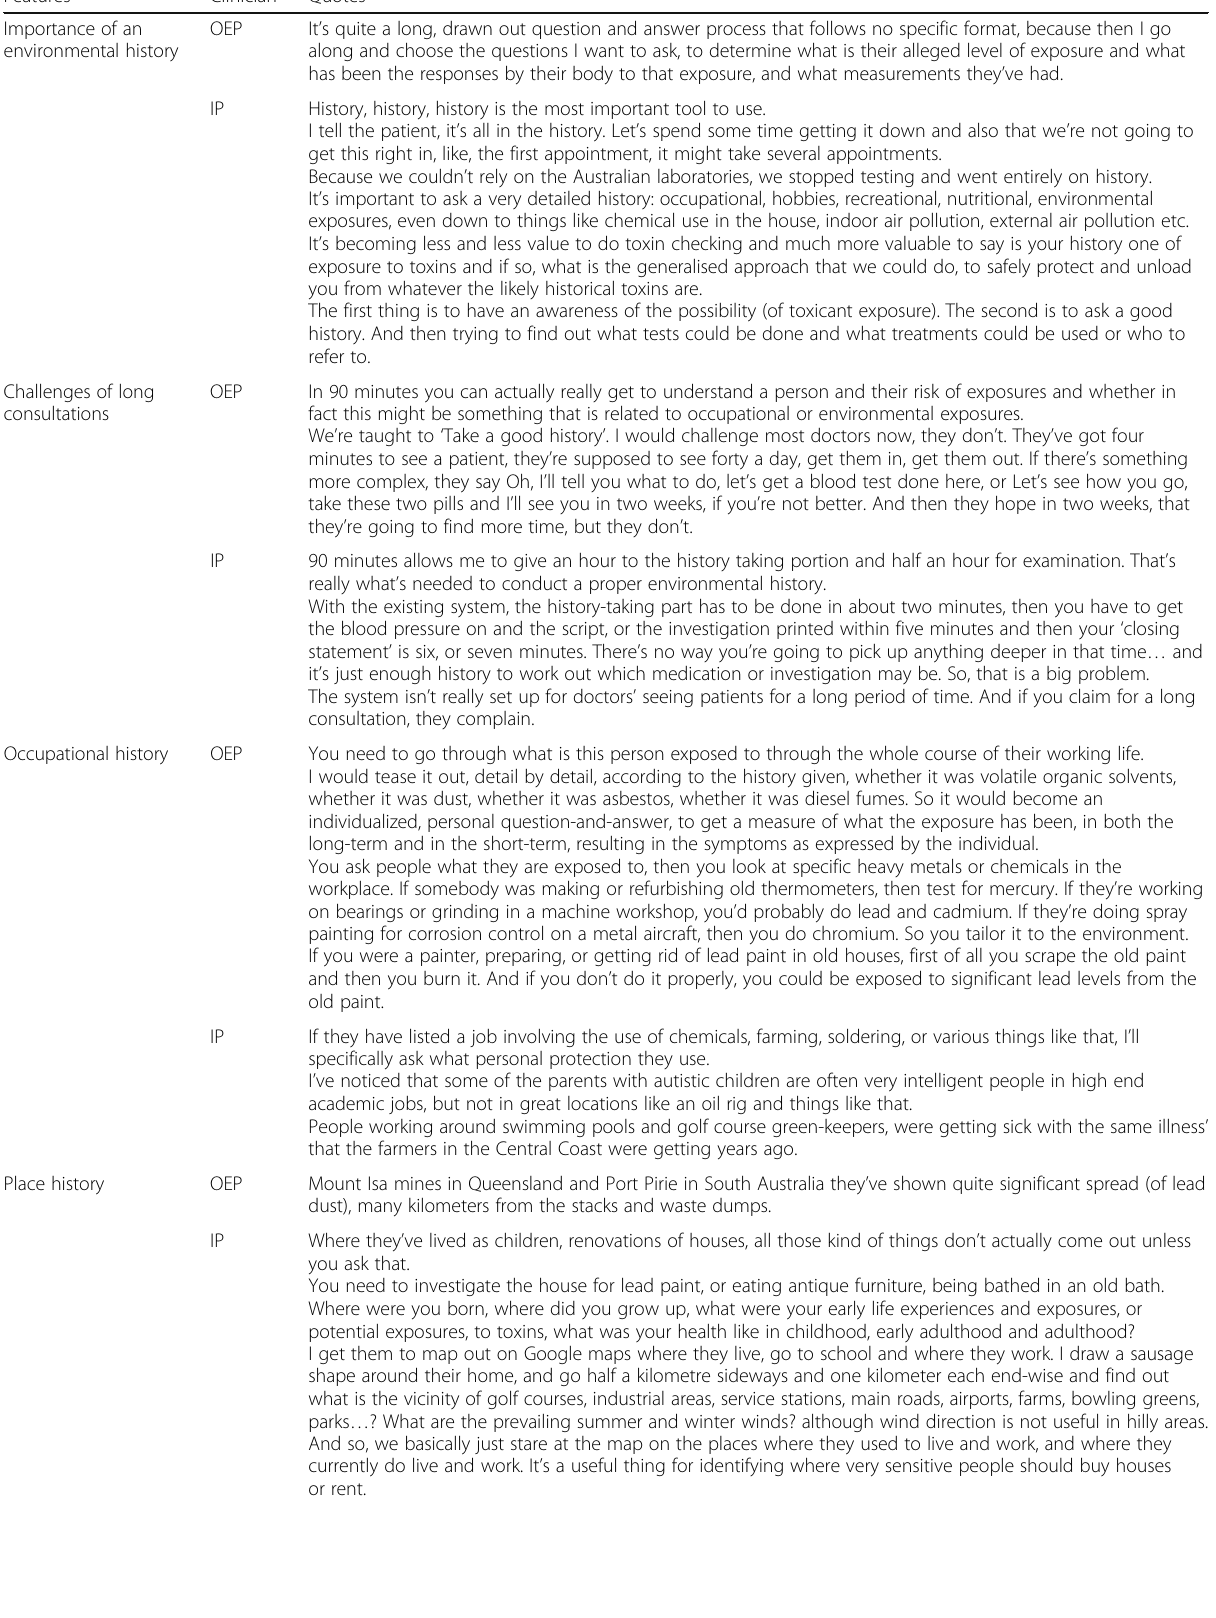
Table 3 The environmental exposure history is the most important clinical tool